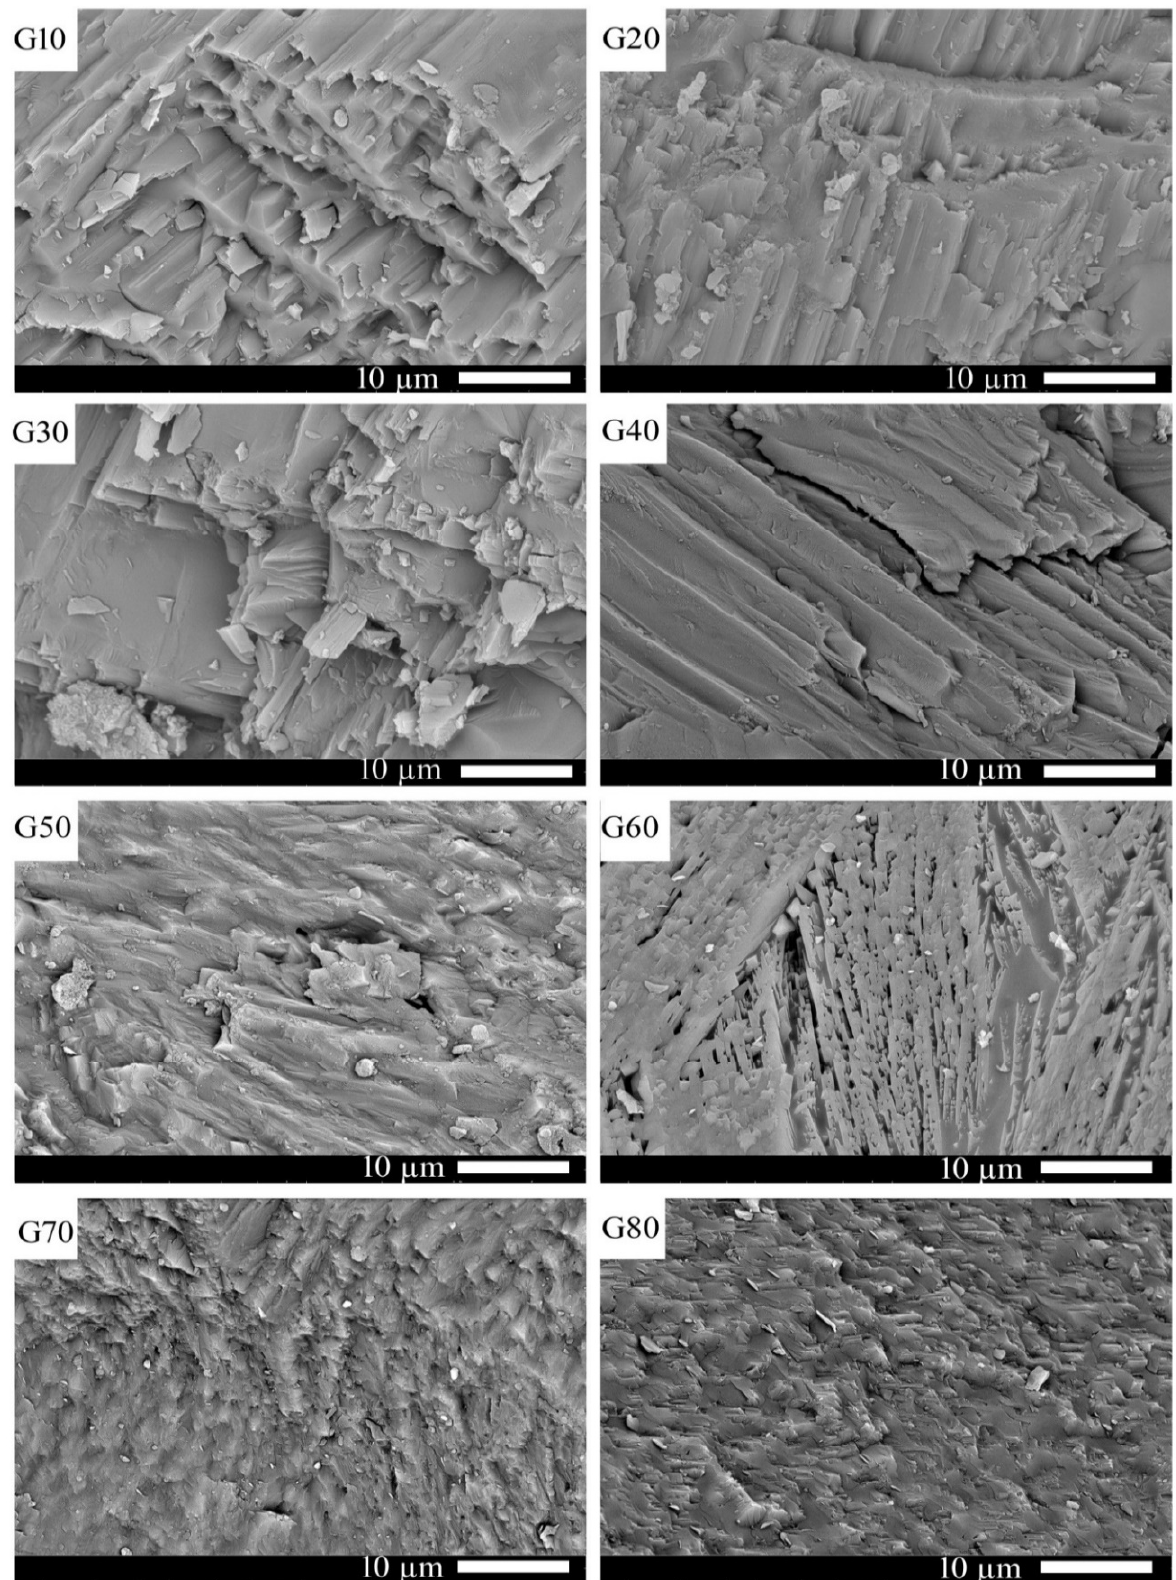
Figure 5. SEM micrographs of the investigated samples after heat ‐ treatment at 1000 °C for 2 h.